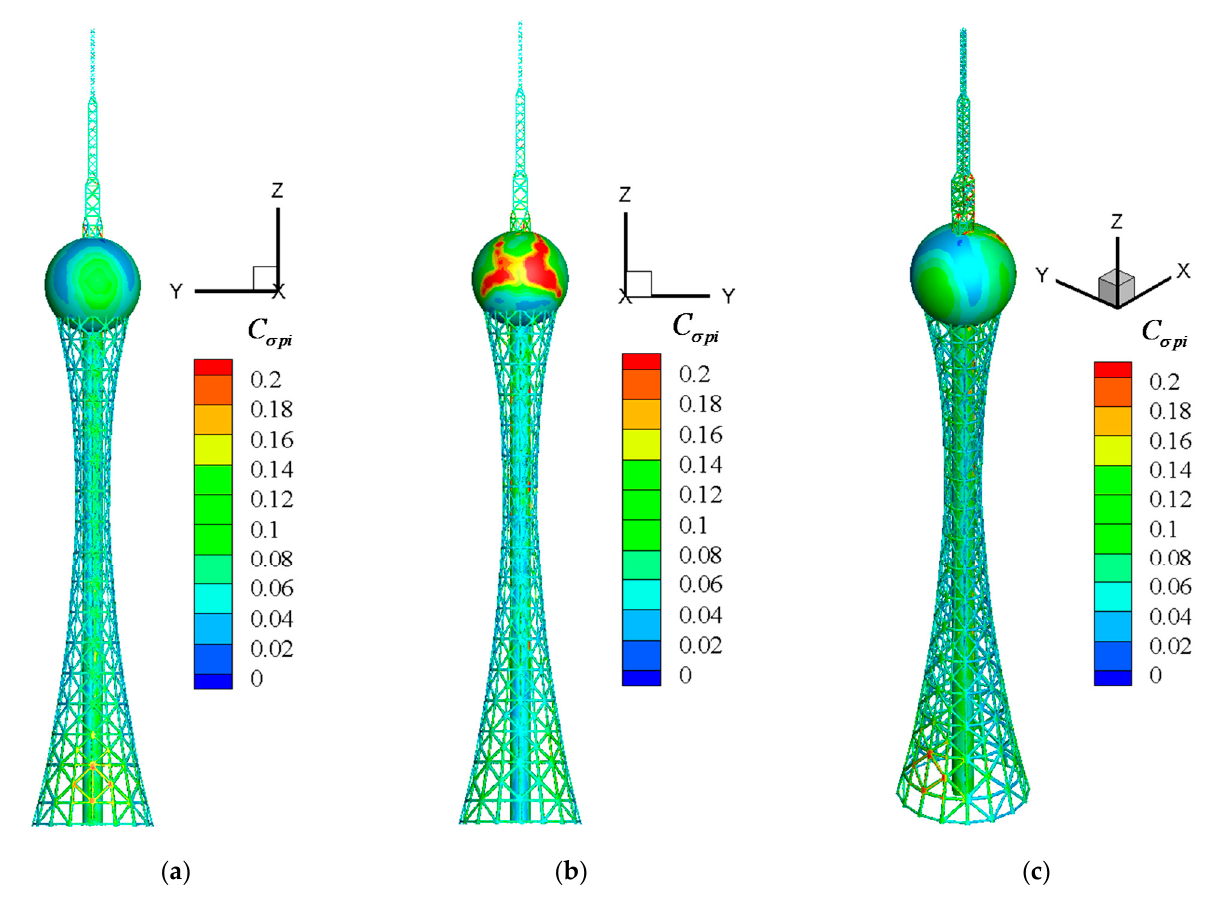
Figure 23. Fluctuating wind pressure coefficient distribution of the TV tower with the grid structure. ( a ) Windward side; ( b ) Windward side; ( c ) Windward and lateral sides.